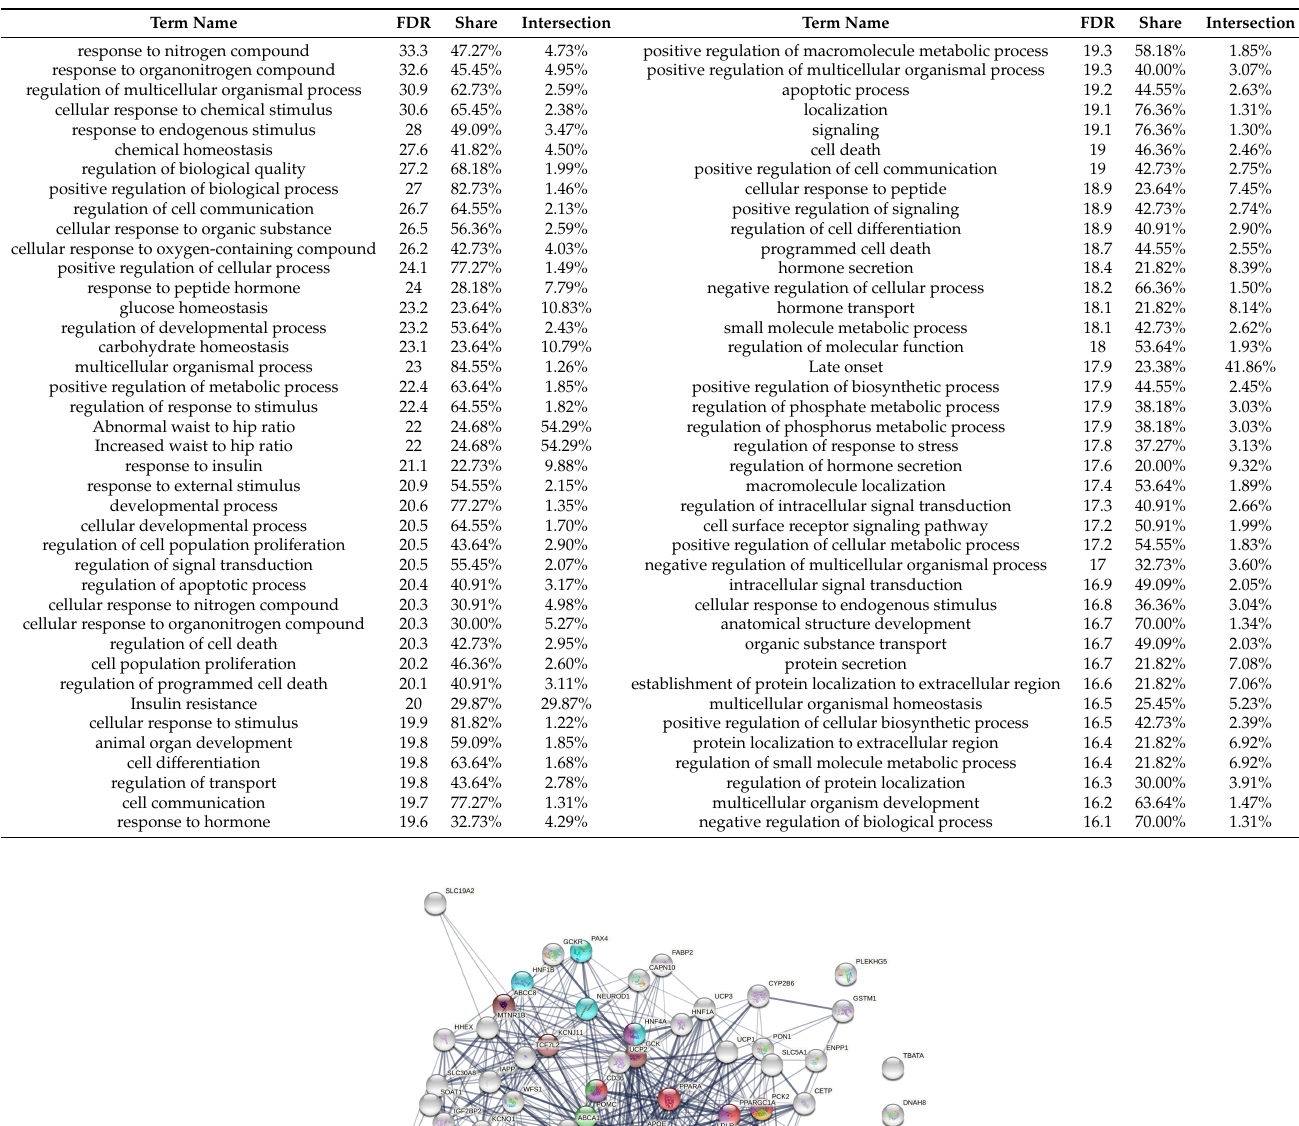
Table 1. The analysis of gene enrichment of the most frequently found diabetes-related genes in the literature (-log-pvalue ≥ 16). The biological pathways with false discovery rate (FDR). The intersection ratio represents how many of the termed known genes are found within the studied list, and the share ratio how many of the genes belong to this biological pathway.